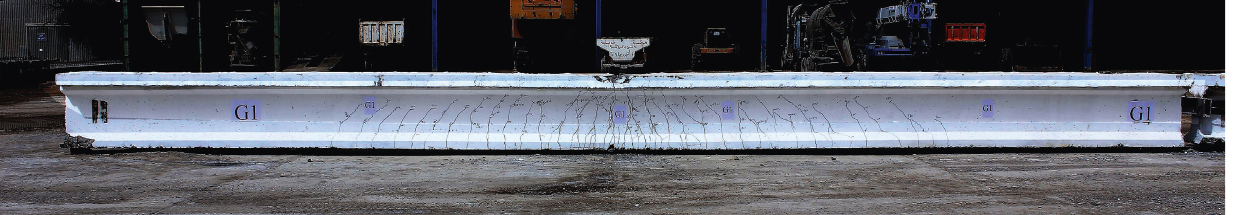
Figure 6: Crack pattern of girder G1 after testing.